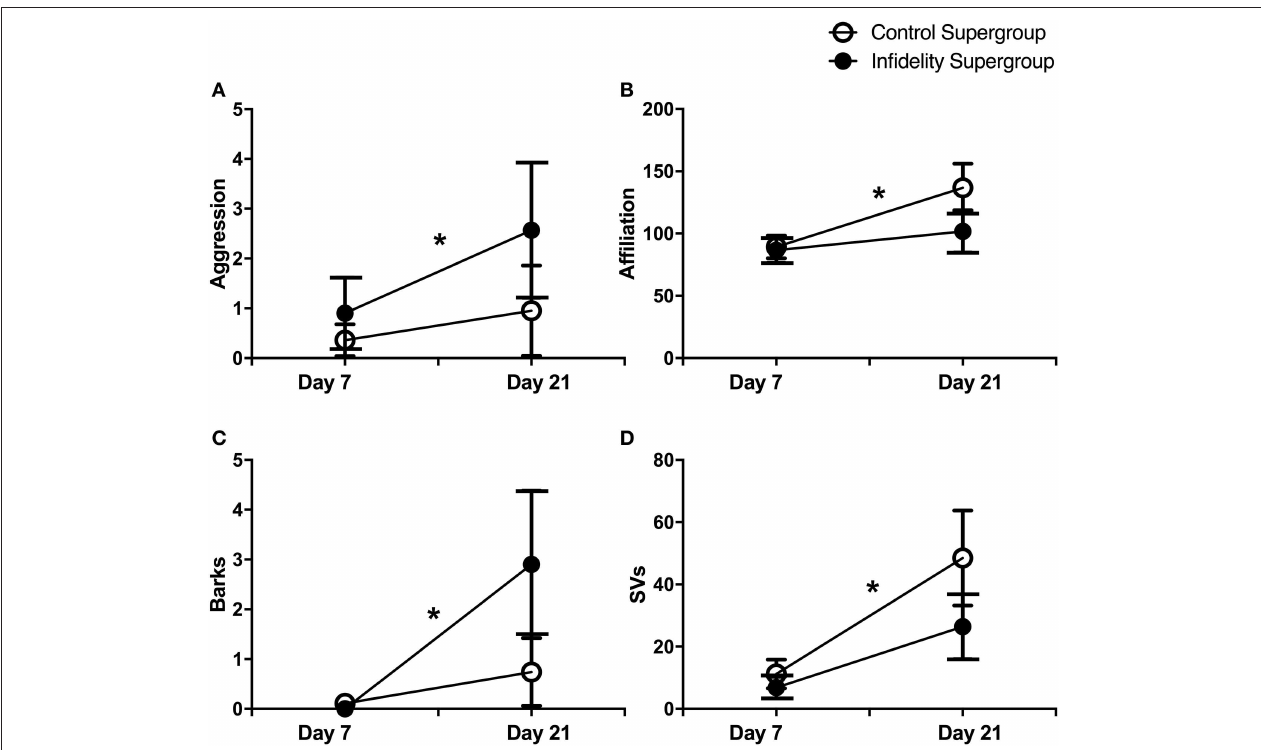
FIGURE 4 | Impacts of social challenge on pair behavior and USVs. Changes in aggression and USVs from pair development (day 7; pre-social challenge treatment) to pair reunion (day 21; post-social challenge treatment) shown for “control supergroup” (i.e., separation and no-separation control pairs pooled) and “infidelity supergroup” (i.e., male infidelity challenge and female infidelity challenge pairs pooled). (A) Increase in aggression for the infidelity supergroup ( N = 21), but no change for the control supergroup ( N = 22). (B) Increase in affiliation for the control supergroup ( N = 22) but no change for the infidelity supergroup ( N = 21). (C) Increase in barks for the infidelity supergroup ( N = 20) but no change for the control supergroup ( N = 19). (D) Increase in SVs for the control supergroup ( N = 19), but no change for the infidelity supergroup ( N = 20). Wilcoxon signed rank tests, * P ≤ 0.05.